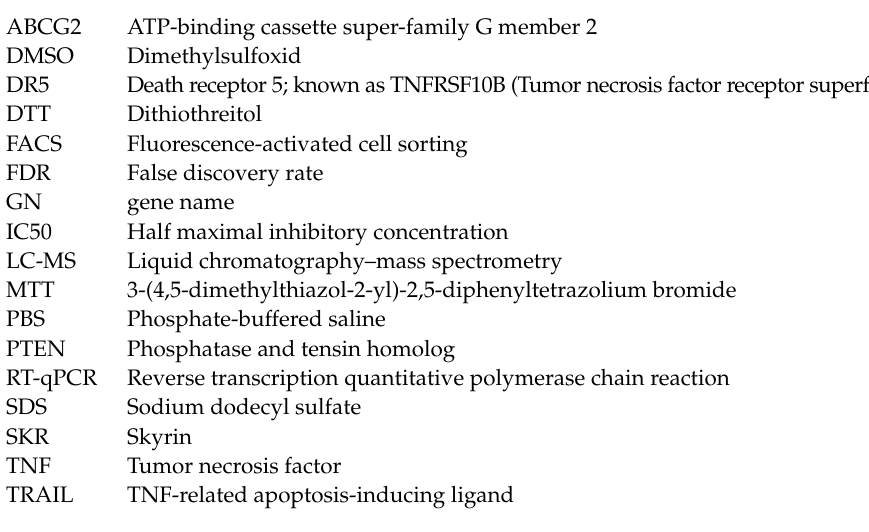
oligonucleotide primers DR4_for and DR4_rev, Figure S42: Melt curve after of the TNF (TNF alpha)